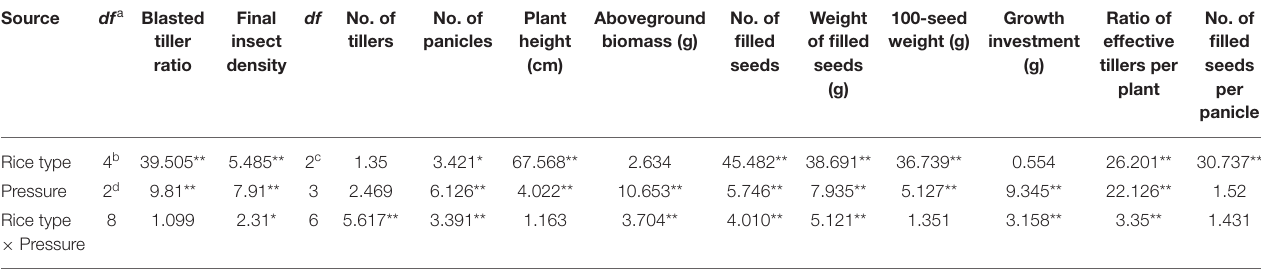
TABLE 1 | F -values generated from two-way ANOVA testing the effects of insect pressure, rice type, and their interaction on insect damage and final insect density and fitness-related traits. Source df a Blasted No. of